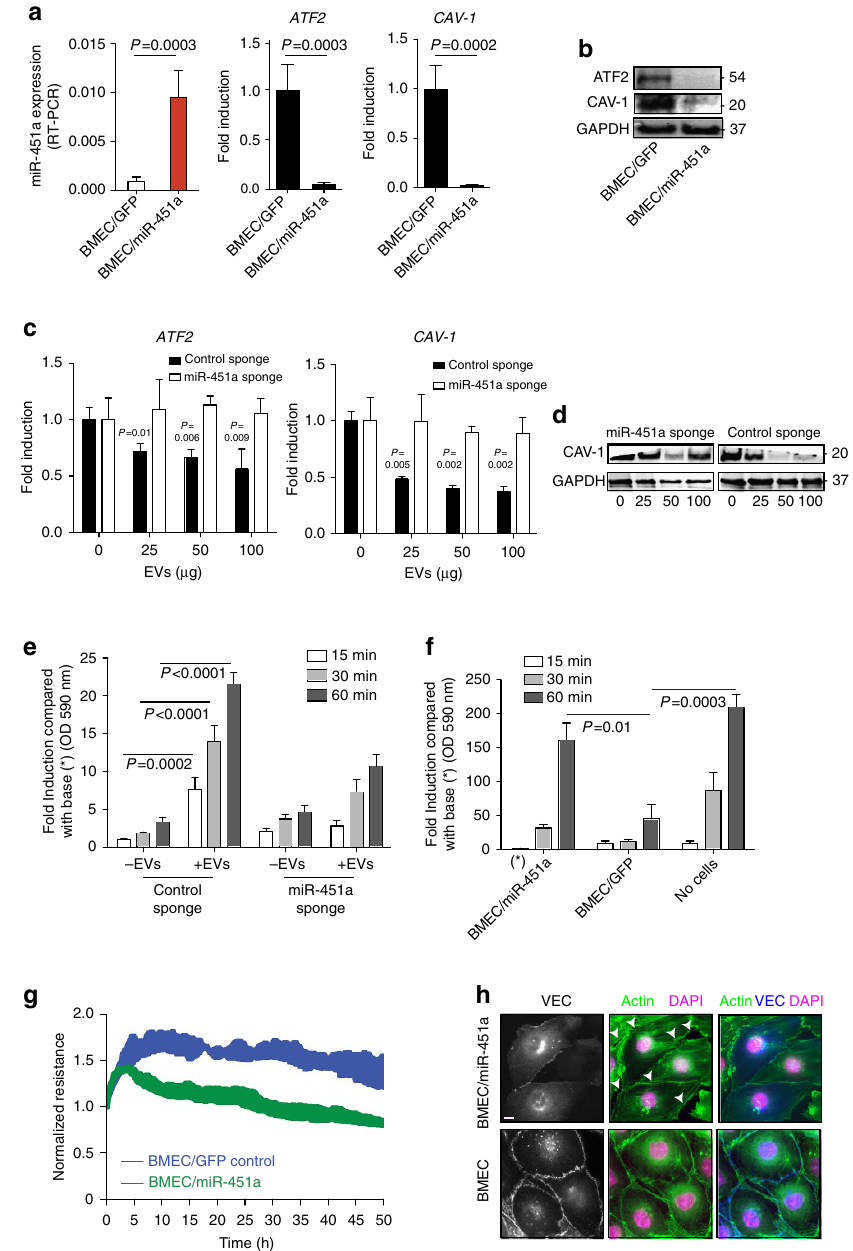
Figure 8 | miR-451a alters endothelial barrier properties. ( a , b ) Effect of miR-451a over-expression. Endothelial cells were transduced with a lentiviral vector expressing miR-451a (BMEC/miR-451a) or GFP control (BMEC/GFP). Expression of CAV-1 and ATF2 was assessed on a transcript level by qRT-PCR ( a ) and on a protein level by western blot ( b ). At both levels the two markers are significantly reduced in BMEC/miR-451a compared with GFP control and wild-type BMEC. qRT-PCR results are normalized by the 2 -Ct method using GAPDH , and expressed as mean ( ± s.e.m.) ( n ¼ 3 experiments), p versus control (Student’s t -test). ( c , d ) miRNA inhibition via miRNA Sponge. Endothelial cells were transduced with miR-451a Sponge miRNA or control Sponge miRNA before addition of EVs and target gene and protein expression in endothelial cells was determined by qRT-PCR ( c ) and western blot ( d ). Expression of both target genes, CAV-1 and ATF2 , is restored compared with BMECs transduced with control Sponge. qRT-PCR results are normalized by the 2 -Ct method using EF-1 , and with 18S rRNA as a reference and expressed as mean ( ± s.e.m.) fold induction over untreated control ( n ¼ 3 experiments), P versus control (Student’s t -test). ( e ) Permeability of BMECs transduced with miR-451a Sponge or control Sponge was assessed by measuring the appearance of rhodamine-labelled dextran in the bottom well of a trans-well set up after a 1hour time-course. The absorbance at 15, 30 and 60min time points was compared with the control Sponge condition. Data represent mean ( ± s.e.m., n ¼ 6), P versus control (Student’s t -test). ( f , g ) Altered barrier properties in BMEC/miR-451a line. Permeability assays using rhodamine-labeled dextran ( f ) and TEER assays ( g ) were performed over time, with BMEC/miR-451a and the BMEC/GFP control line. Both experimental approaches demonstrate significant reduction in endothelial barrier properties in BMEC/miR-451a compared with control. ( h ) BMEC control and BMEC/miR-451a cells were plated for 36h before fixation, permeabilization and staining for actin and the junctional protein VE-cadherin (VEC). White arrows indicate presence of gaps in the BMEC/miR-451a line. Scale bar, 10 m m. TEER, trans-endothelial electrical